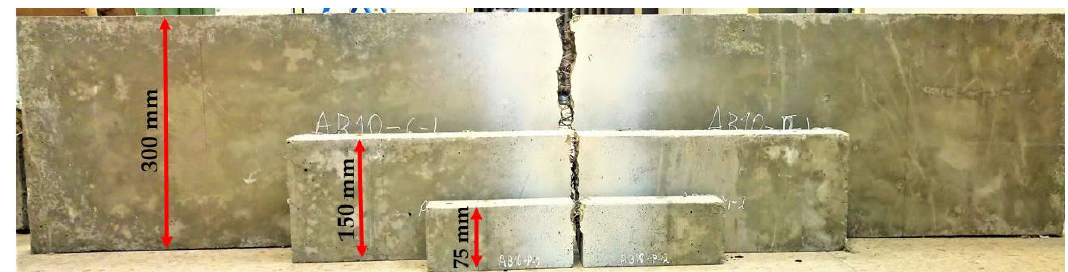
Figure 4. Photo of the three sizes of the tested specimens.